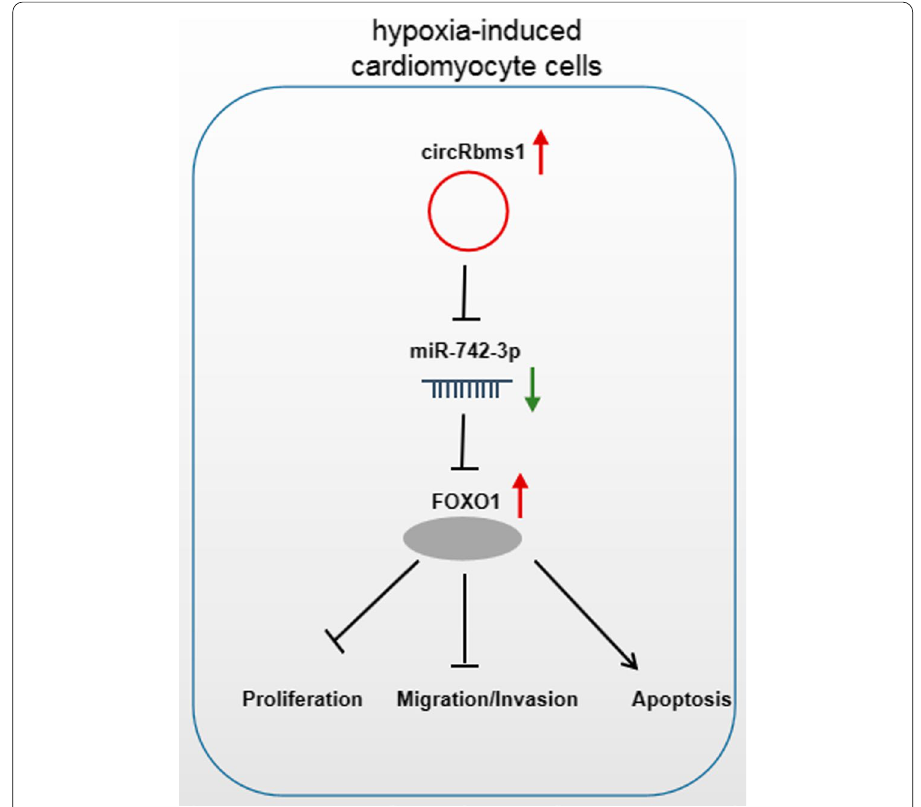
Fig. 8 Mechanism diagram for this study. In hypoxia-induced cardiomyocyte cells, circRbms1 inhibited proliferation, migration, and invasion, while promoting apoptosis by regulating miR-742-3p /